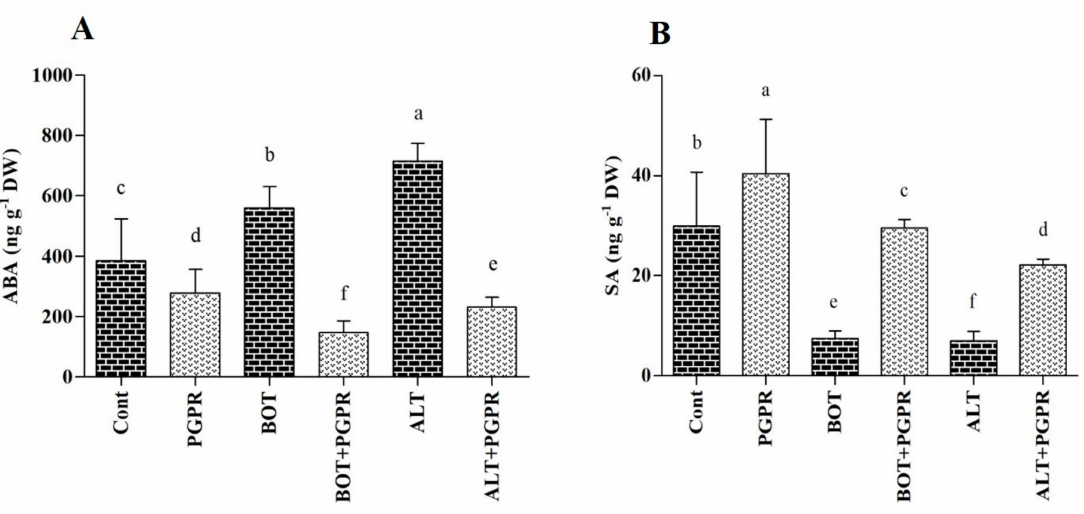
Figure 5. ( A ) Abscisic acid and ( B ) salicylic acid contents in the leaves of peppers grown under normal and stress conditions and treated with plant growth-promoting rhizobacteria (PGPR) after eight days. Treatment: Cont (control), PGPR ( Bacillus amyloliquefaciens ), BOT ( Botrytis pelargonii ), PGPR + BOT ( Bacillus amyloliquefaciens + Botrytis pelargonii ), ALT ( Alternaria alternata ), PGPR + ALT ( Bacillus amyloliquefaciens + Alternaria alternata ). Values show the means ± standard error ( n = 3) and significant differences are indicated at p < 0.05 in accordance with the least significant difference test. Bars with different letters are significantly different from each